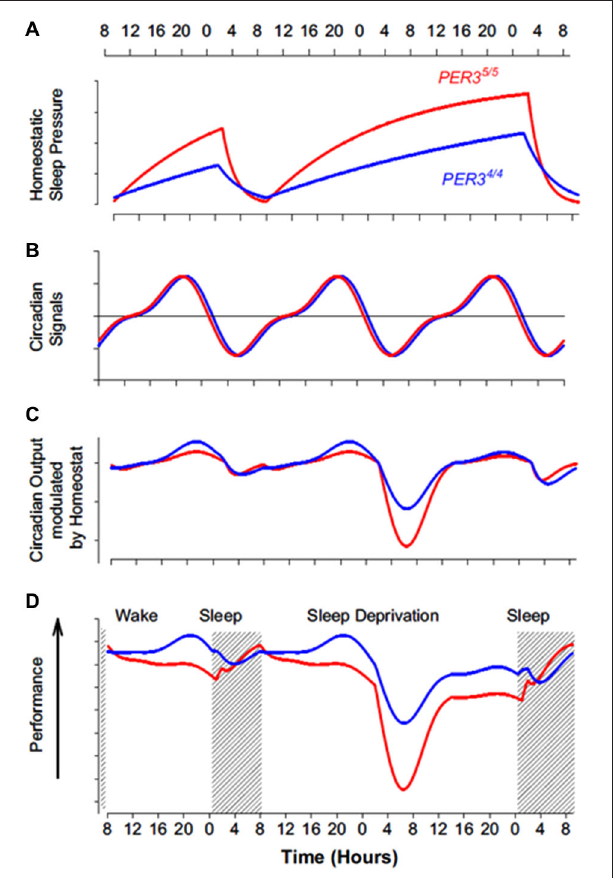
FIGURE 2 | Impact of the interaction between homeostatic sleep pressure and circadian process on cognitive performance in PER3 4 / 4 (blue line) and PER3 5 / 5 (red line) individuals . (A) As indicated by slow wave activity (SWA) measure, PER3 5 / 5 have a faster build-up during wakefulness and a quicker dissipation during sleep of homeostatic sleep pressure (based on data from Viola et al. (2007)). (B) Regarding circadian phase, PER3 4 / 4 and PER3 5 / 5 do not appear to differ, as indicated by melatonin, cortisol, and PER3 mRNA measures (based on data from Viola et al. (2007)). Note that the circadian signal increasingly promotes wakefulness during the day (positive value, above horizontal line) and increasingly promotes sleep during the night (negative value, below horizontal line). (C) Theoretical modulation of the circadian signal by homeostatic sleep pressure in both PER3 genotypes. The difference in homeostatic sleep pressure results in a limited difference in the output of this interaction during a normal waking day. The output of the interaction affects much more negatively wakefulness of PER3 5 / 5 in the absence of overnight sleep, particularly in the early morning hours when the circadian system maximally promotes sleep. (D) Composite measures of performance in both PER3 genotypes, based on extended neurophychological test batteries (Viola et al., 2007). Performance profile closely follow theoretical interaction between circadian and sleep homeostasis processes depicted in C . This model could speculatively be applied to extremes morning and evening chronotypes, which also differ in term of homeostatic sleep pressure build up (Mongrain and Dumont, 2007) (but also they differ sometimes in term of circadian phase angle with sleep (Mongrain et al., 2006a)). [Copied with permission from Dijk and Archer (2010)]. sessions (low vs. high homeostatic sleep pressure) revealed an apparent double dissociation between the genotypes ( Figure 3